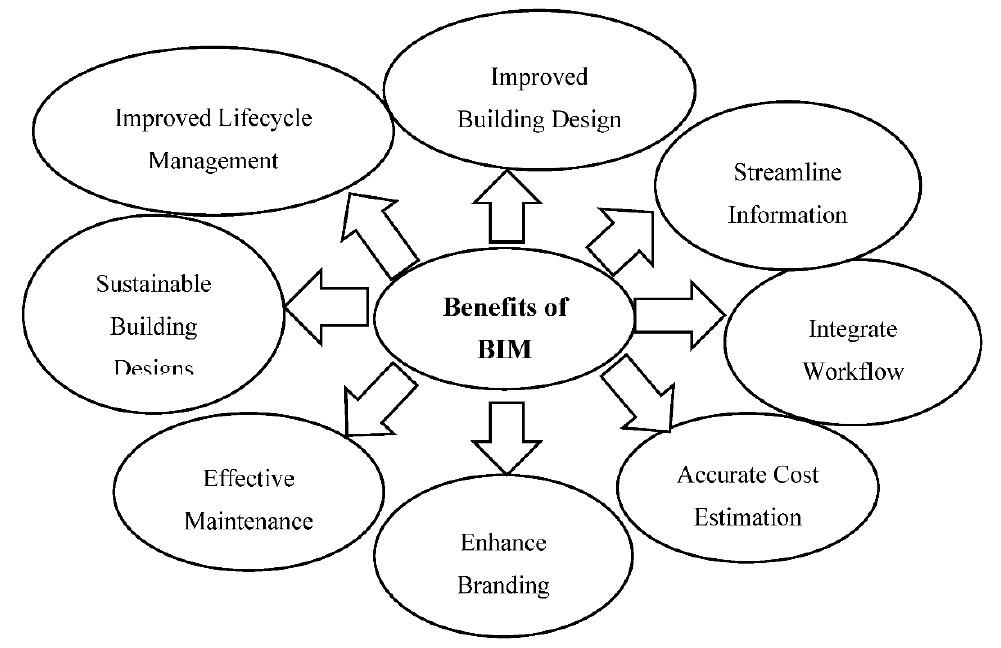
Figure 5. The benefits of the building information model.